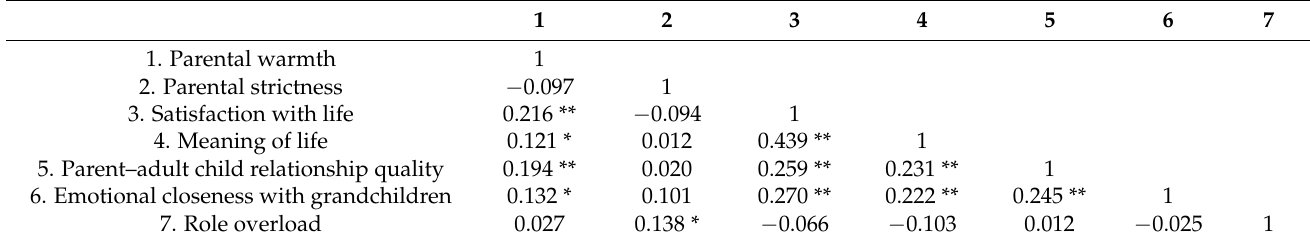
Table 1. Correlations between parenting dimensions and grandparenting functioning.